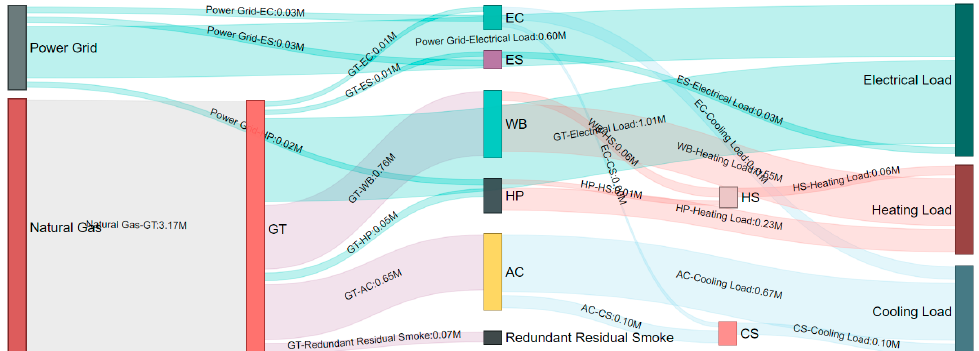
( c ) absorption chiller; ( d ) waste-heat boiler.